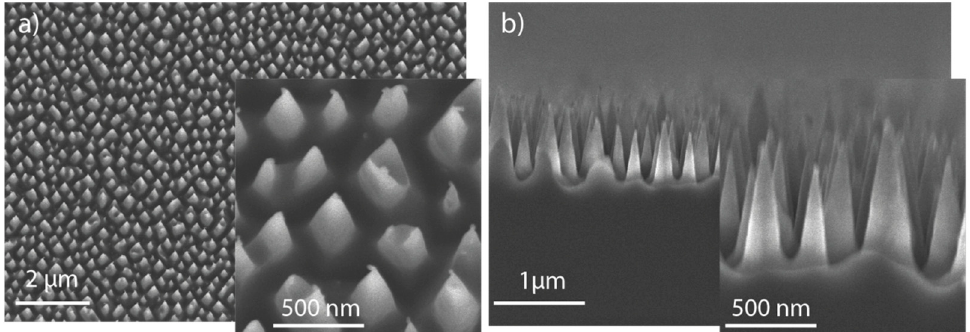
Figure 1. Scanning electron microscopy images of the nanostructured Si substrate: ( a ) top view of the silicon needles with a tilt angle of 15°; ( b ) cross section of the substrate providing a side view of the silicon needles.